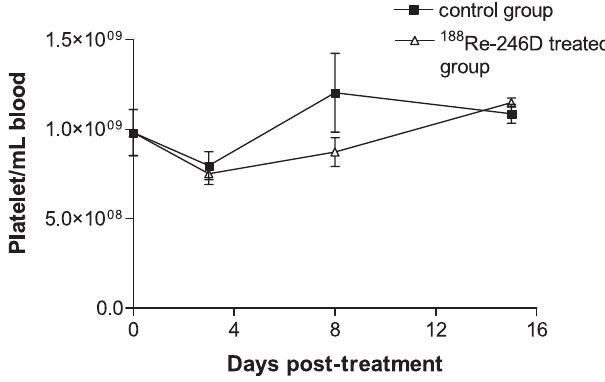
Figure 4. Effect of RIT on Platelet Counts in the Peripheral Blood Platelet counts in the blood of SCID mice injected intrasplenically with HIV-1-infected hPBMCs and either treated with 160 l Ci (5.92 MBq) (20 l g) 188 Re-246-D IP 1 h after infection with hPBMCs ( n ¼ 5) or no treatment ( n ¼ 5). The blood was collected from the tail vein on days 0, 4, 8, and 15 post-therapy. Each data point represents the mean of platelet counts in a given group of mice, and error bars show standard error of the mean.